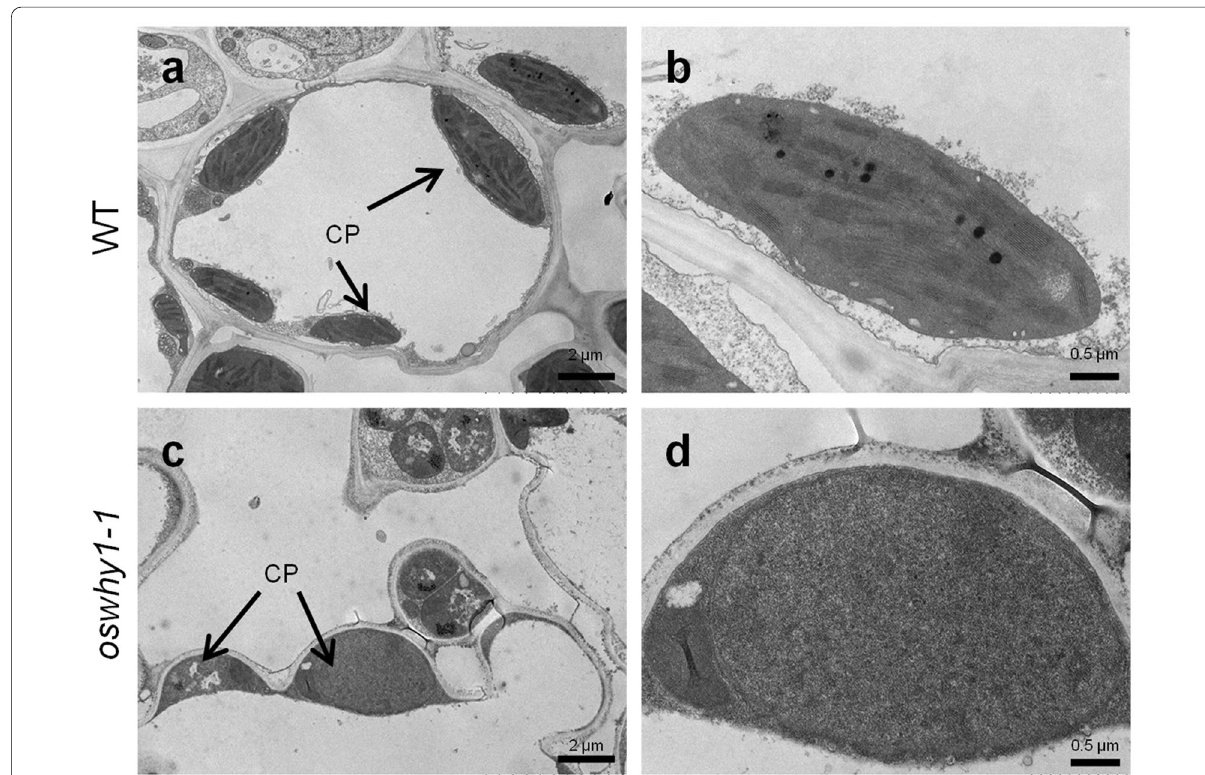
Fig. 3 Transmission electron micrograph (TEM) of chloroplasts in the WT and oswhy1-1 leaves. Chloroplast structures in leaves of the WT ( a , b ) and oswhy1-1 ( c , d ) at the seedling stage. CP, chloroplast. b and d were the enlarged images of a and c . CP, chloroplast. Bar ( a , b ) d ) 0.5 =